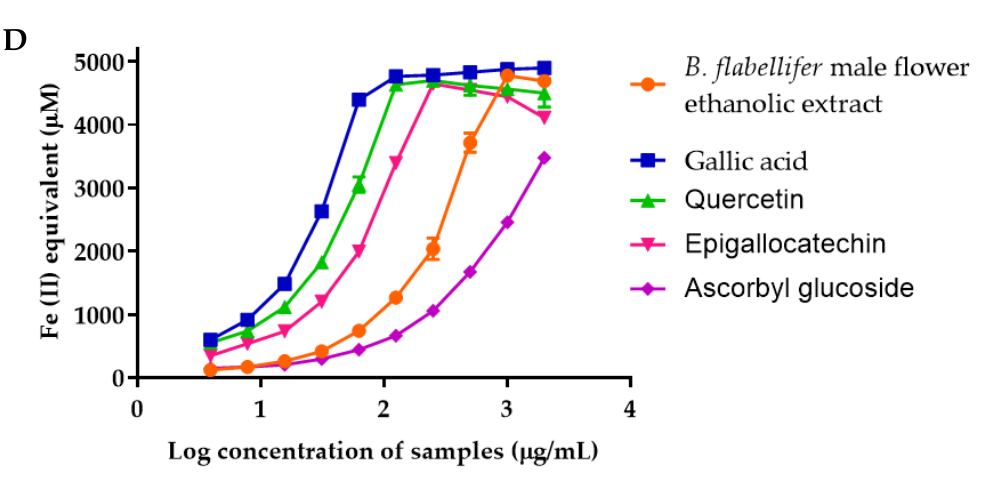
Figure 7. The antioxidant activity of gallic acid, quercetin, epigallocatechin, ascorbyl glucoside, and B. flabellifer flower ethanolic extract determined by ( A ) DPPH free radical scavenging assay, ( B ) ABTS free radical scavenging assay, ( C ) standard curve of ferric reducing antioxidant power assay using ferrous sulfate, ( D ) FRAP assay.